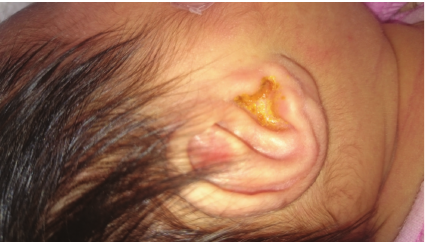
Figure 1: A 23-day-old girl presenting with right ear